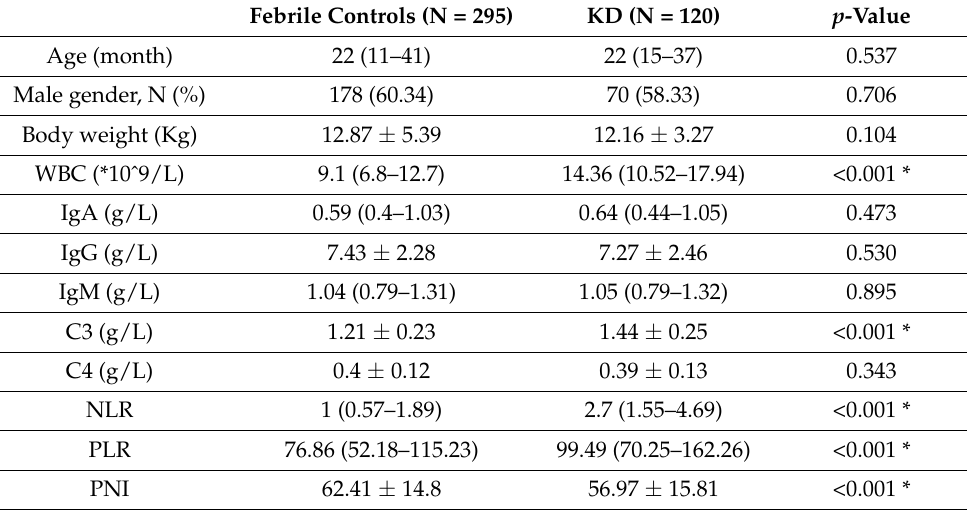
Table 2. Comparison between the Kawasaki disease patients and the febrile controls (the training group).